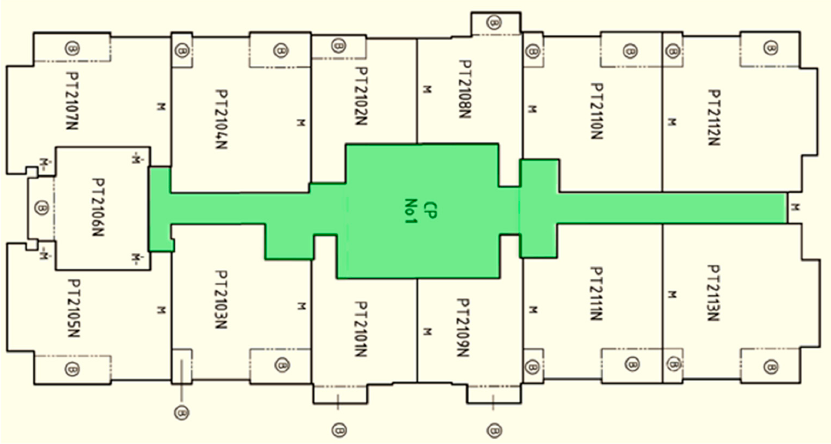
Figure 5. Common property delineated in floor plan diagram.